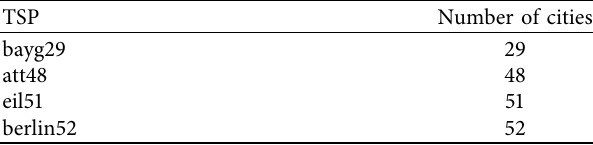
Table 1: TSP datasets for the evaluation experiment.